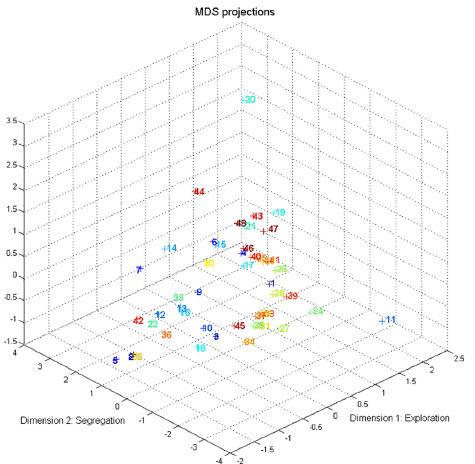
Fig 2. The Kullback-Leibler distances between listener transition matrices visualized on the dimensions extracted by Multi-Dimensional Scaling. Coloured numbers mark the participants.